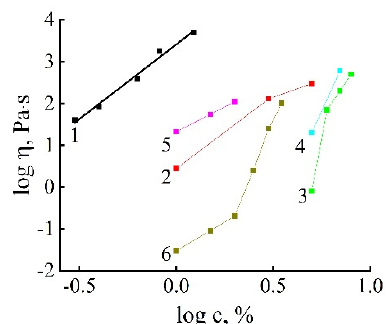
Figure 8. Concentration dependence of viscosity for different cellulose dispersions at 25 °C and γ = 0.1 s − 1 : BC—1, NCC (acidic hydrolysis)—2, NCC—3 [33], NCC—4 [38], MCC—5 [35], cellulose